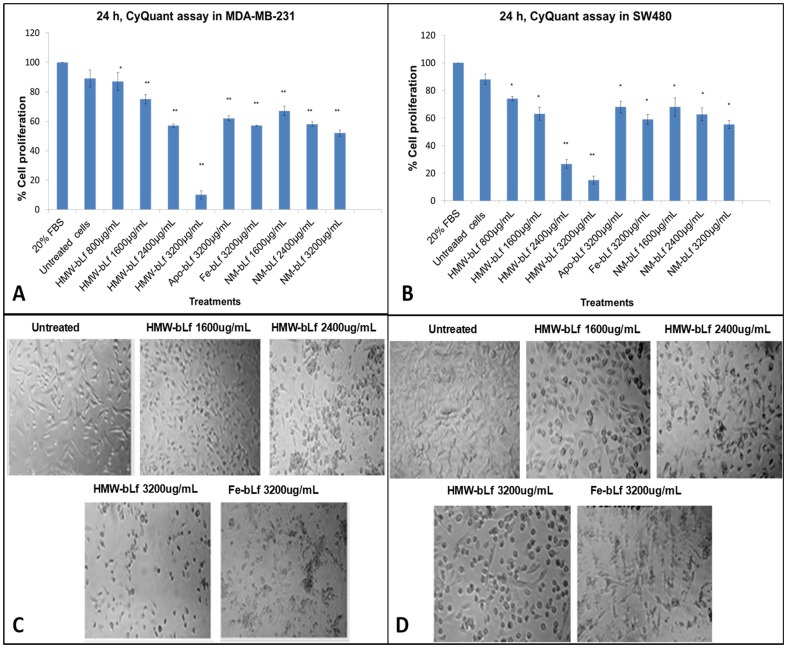
Cell growth inhibition.HMW-bLf decreases the cellular proliferation of MDA-MB-231 and SW480 (A and B respectively) cells in a concentration dependent manner. The cell fate was also monitored by analyzing the cell morphology (C – MDA-MB-231 and D – SW480) which clearly indicates cell death. (* p<0.05 and ** p<0.01)